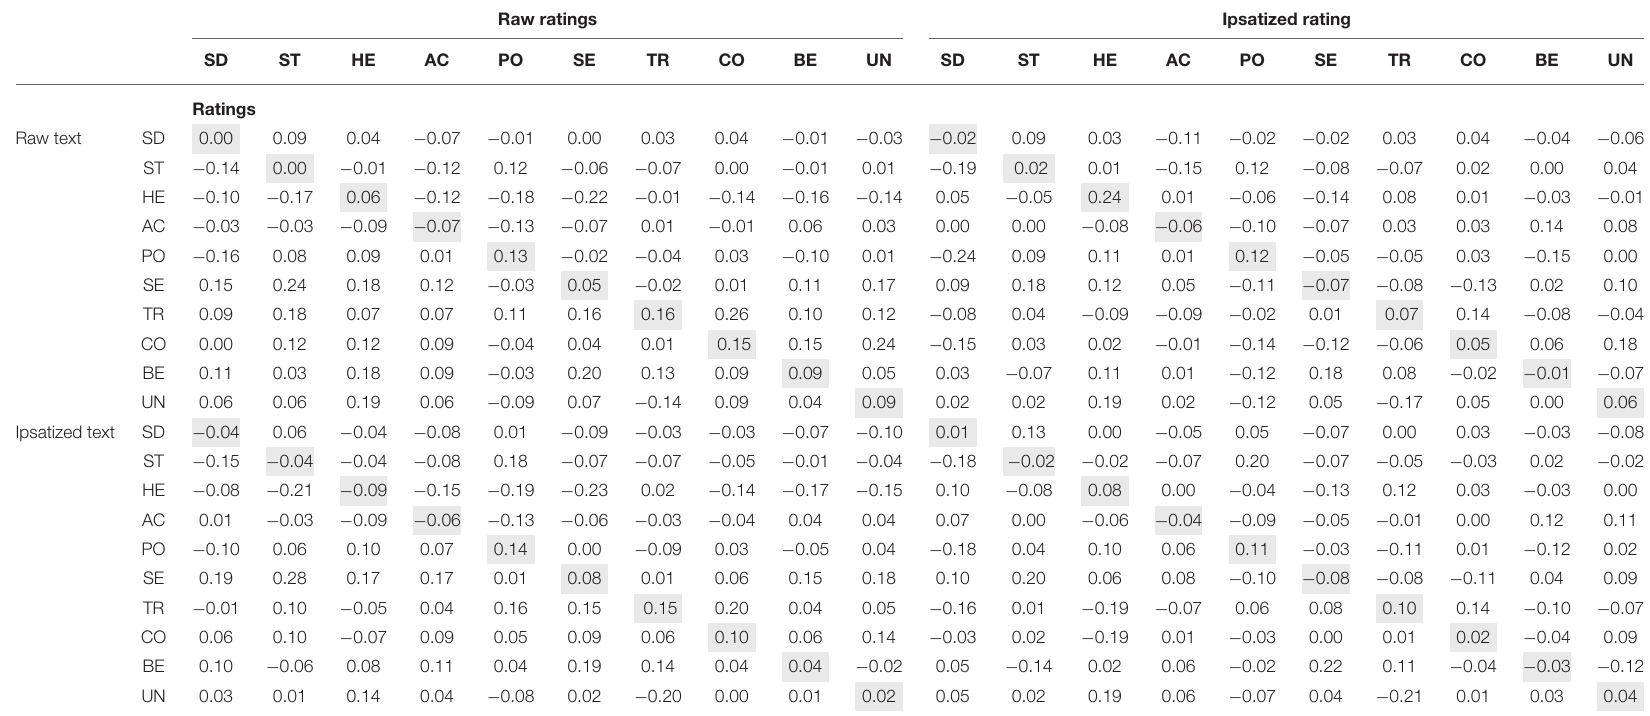
Values above r = 0.19 are significant at p < 0.05. SD, Self direction; ST, Stimulation; HE, Hedonism; AC, Achievement; PO, Power; SE, Security; TR, Tradition; CO, Conformity; BE, Benevolence; UN, Universalism. The meaning of the color indicates the shaded entries show value-type matched